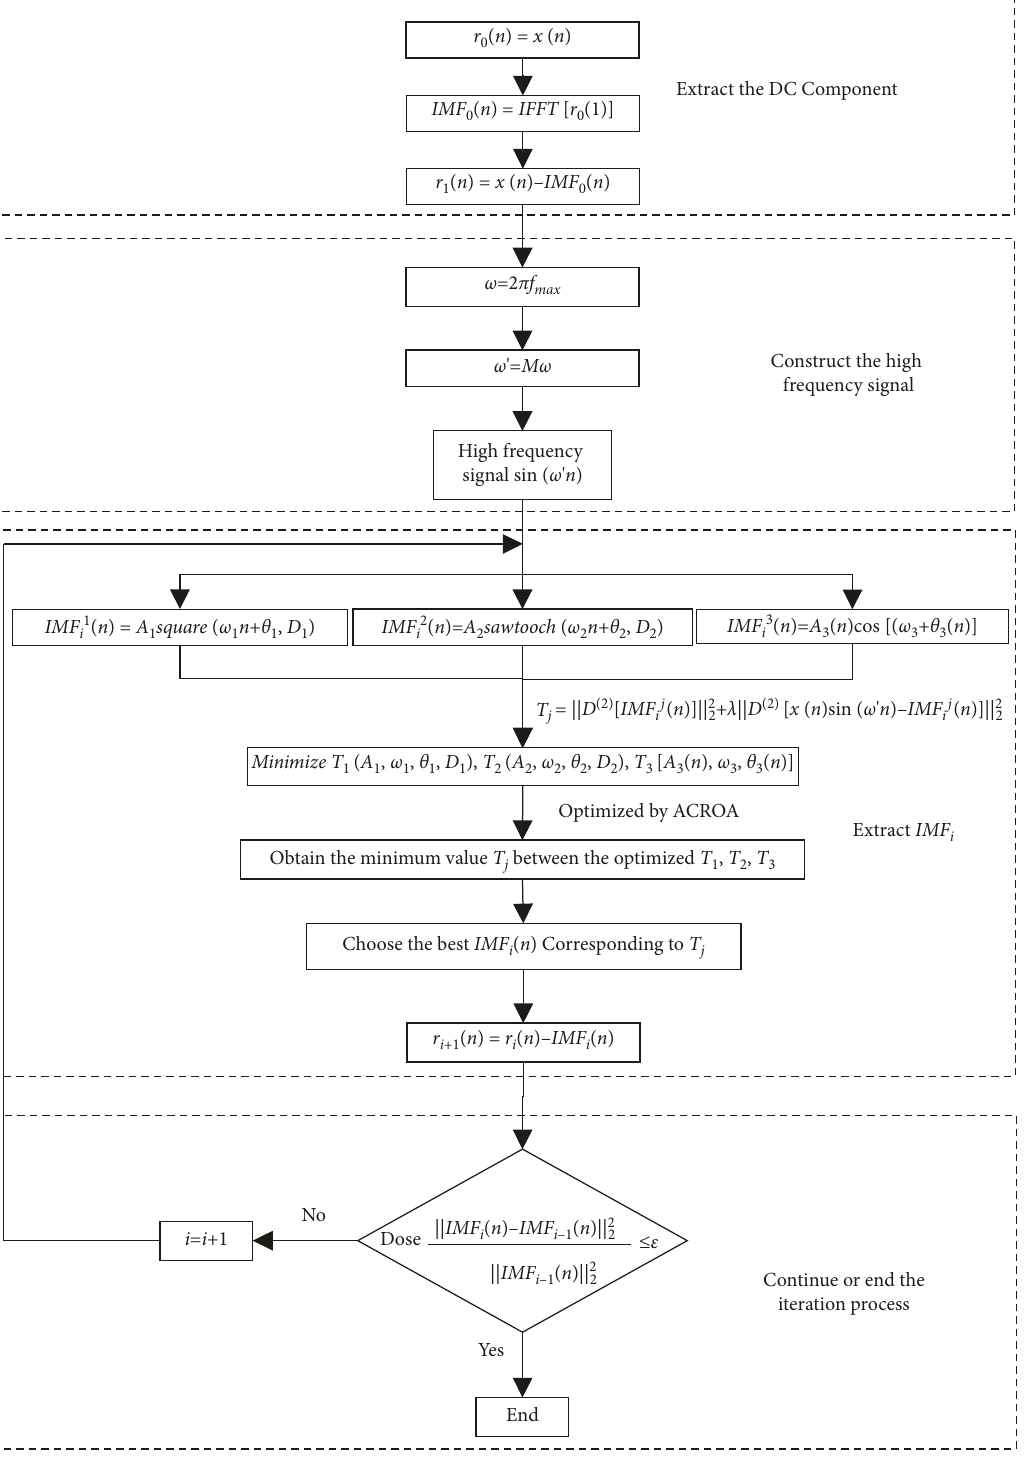
Figure 1: The iteration procedure of